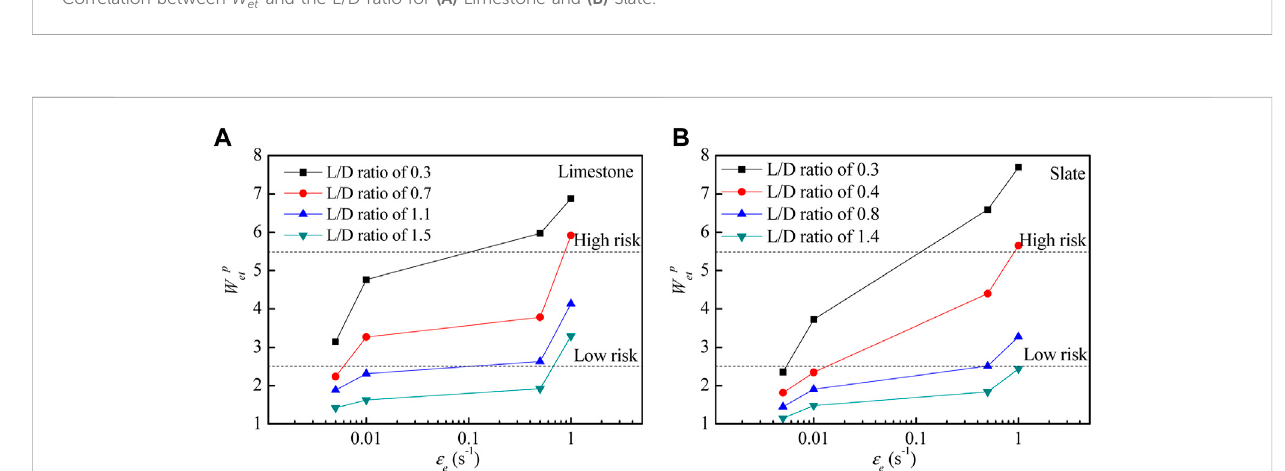
FIGURE 11 Correlation between W p et and ε e under various L/D ratio conditions using the semi-log equation for (A) Limestone and (B)